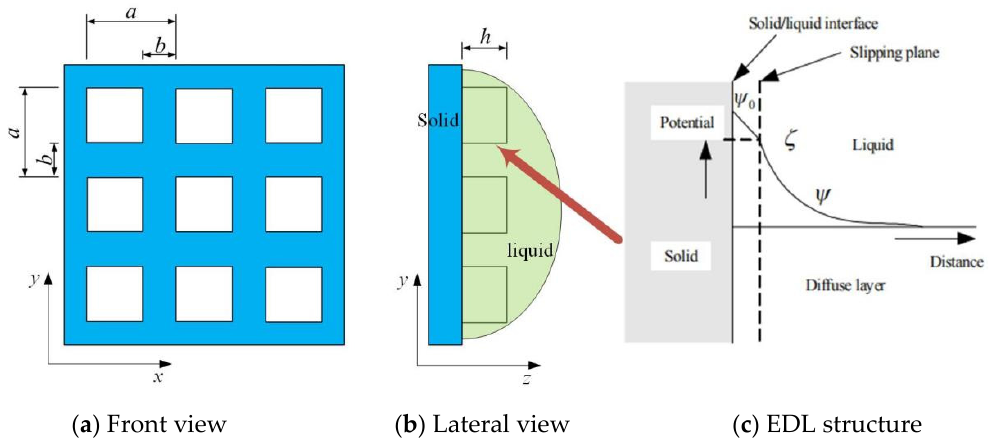
Figure 1. Schematic view of protuberant texture surface and EDL structure: ( a ) front view of surface texture; ( b ) lateral view of surface texture; ( c ) EDL structure at interface of solid and liquid.